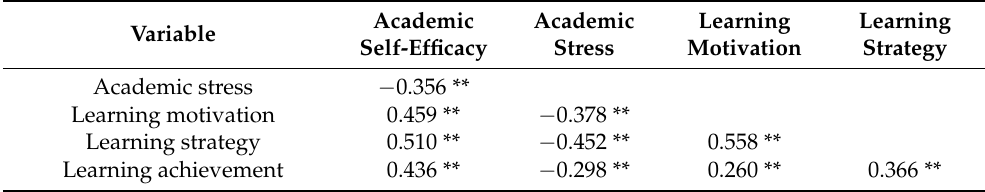
Academic Academic Learning Learning Self-Efficacy Stress Motivation Strategy